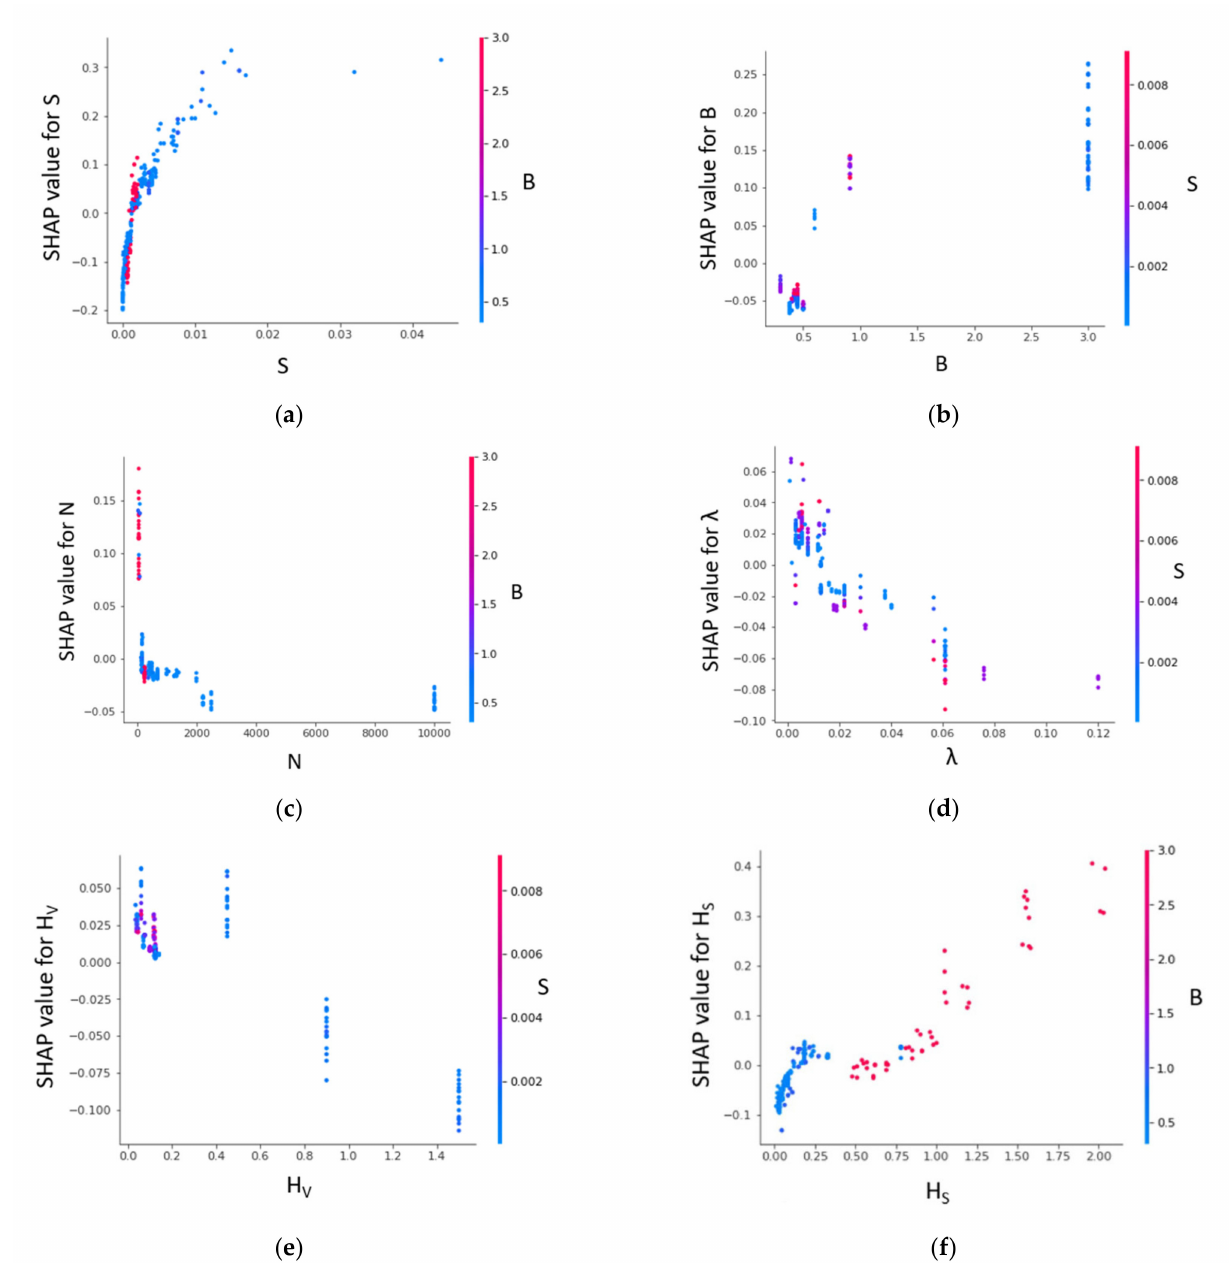
Figure 15. SHAP dependence plot for XGBoost model (U B